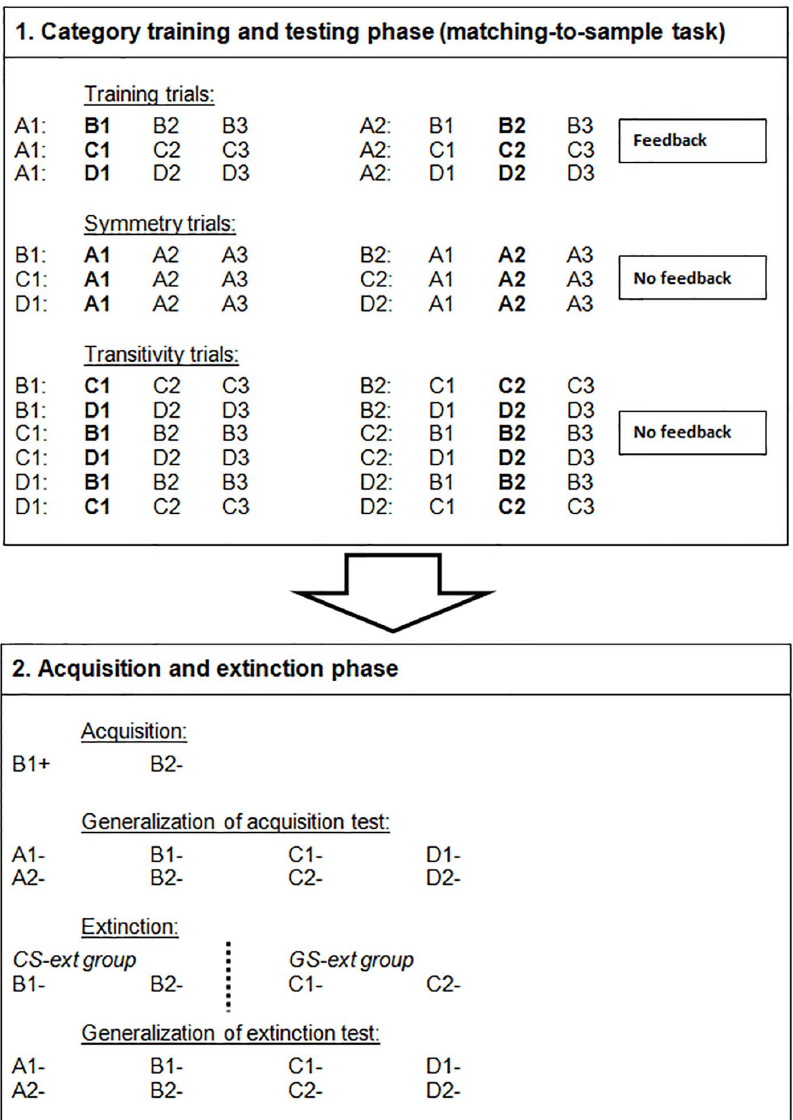
Figure 1. A schematic overview of the experimental phases. The upper panel represents the trials used in the matching-to-sample training, symmetry test and equivalence test, in order to create two novel stimulus categories (A1-B1-C1-D1 and A2-B2-C2-D2). The first stimulus always represents the sample stimulus, the other three stimuli are the comparison stimuli. The correct comparison stimulus is indicated in bold. The lower panel represents the fear conditioning phase (acquisition, generalization of acquisition test, extinction, generalization of extinction test). The ‘‘ + ’’sign indicates that this stimulus is followed by an electric shock in 8 out of 10 trials. The ‘‘ 2 ’’sign indicates that this stimulus is never followed by a shock during those